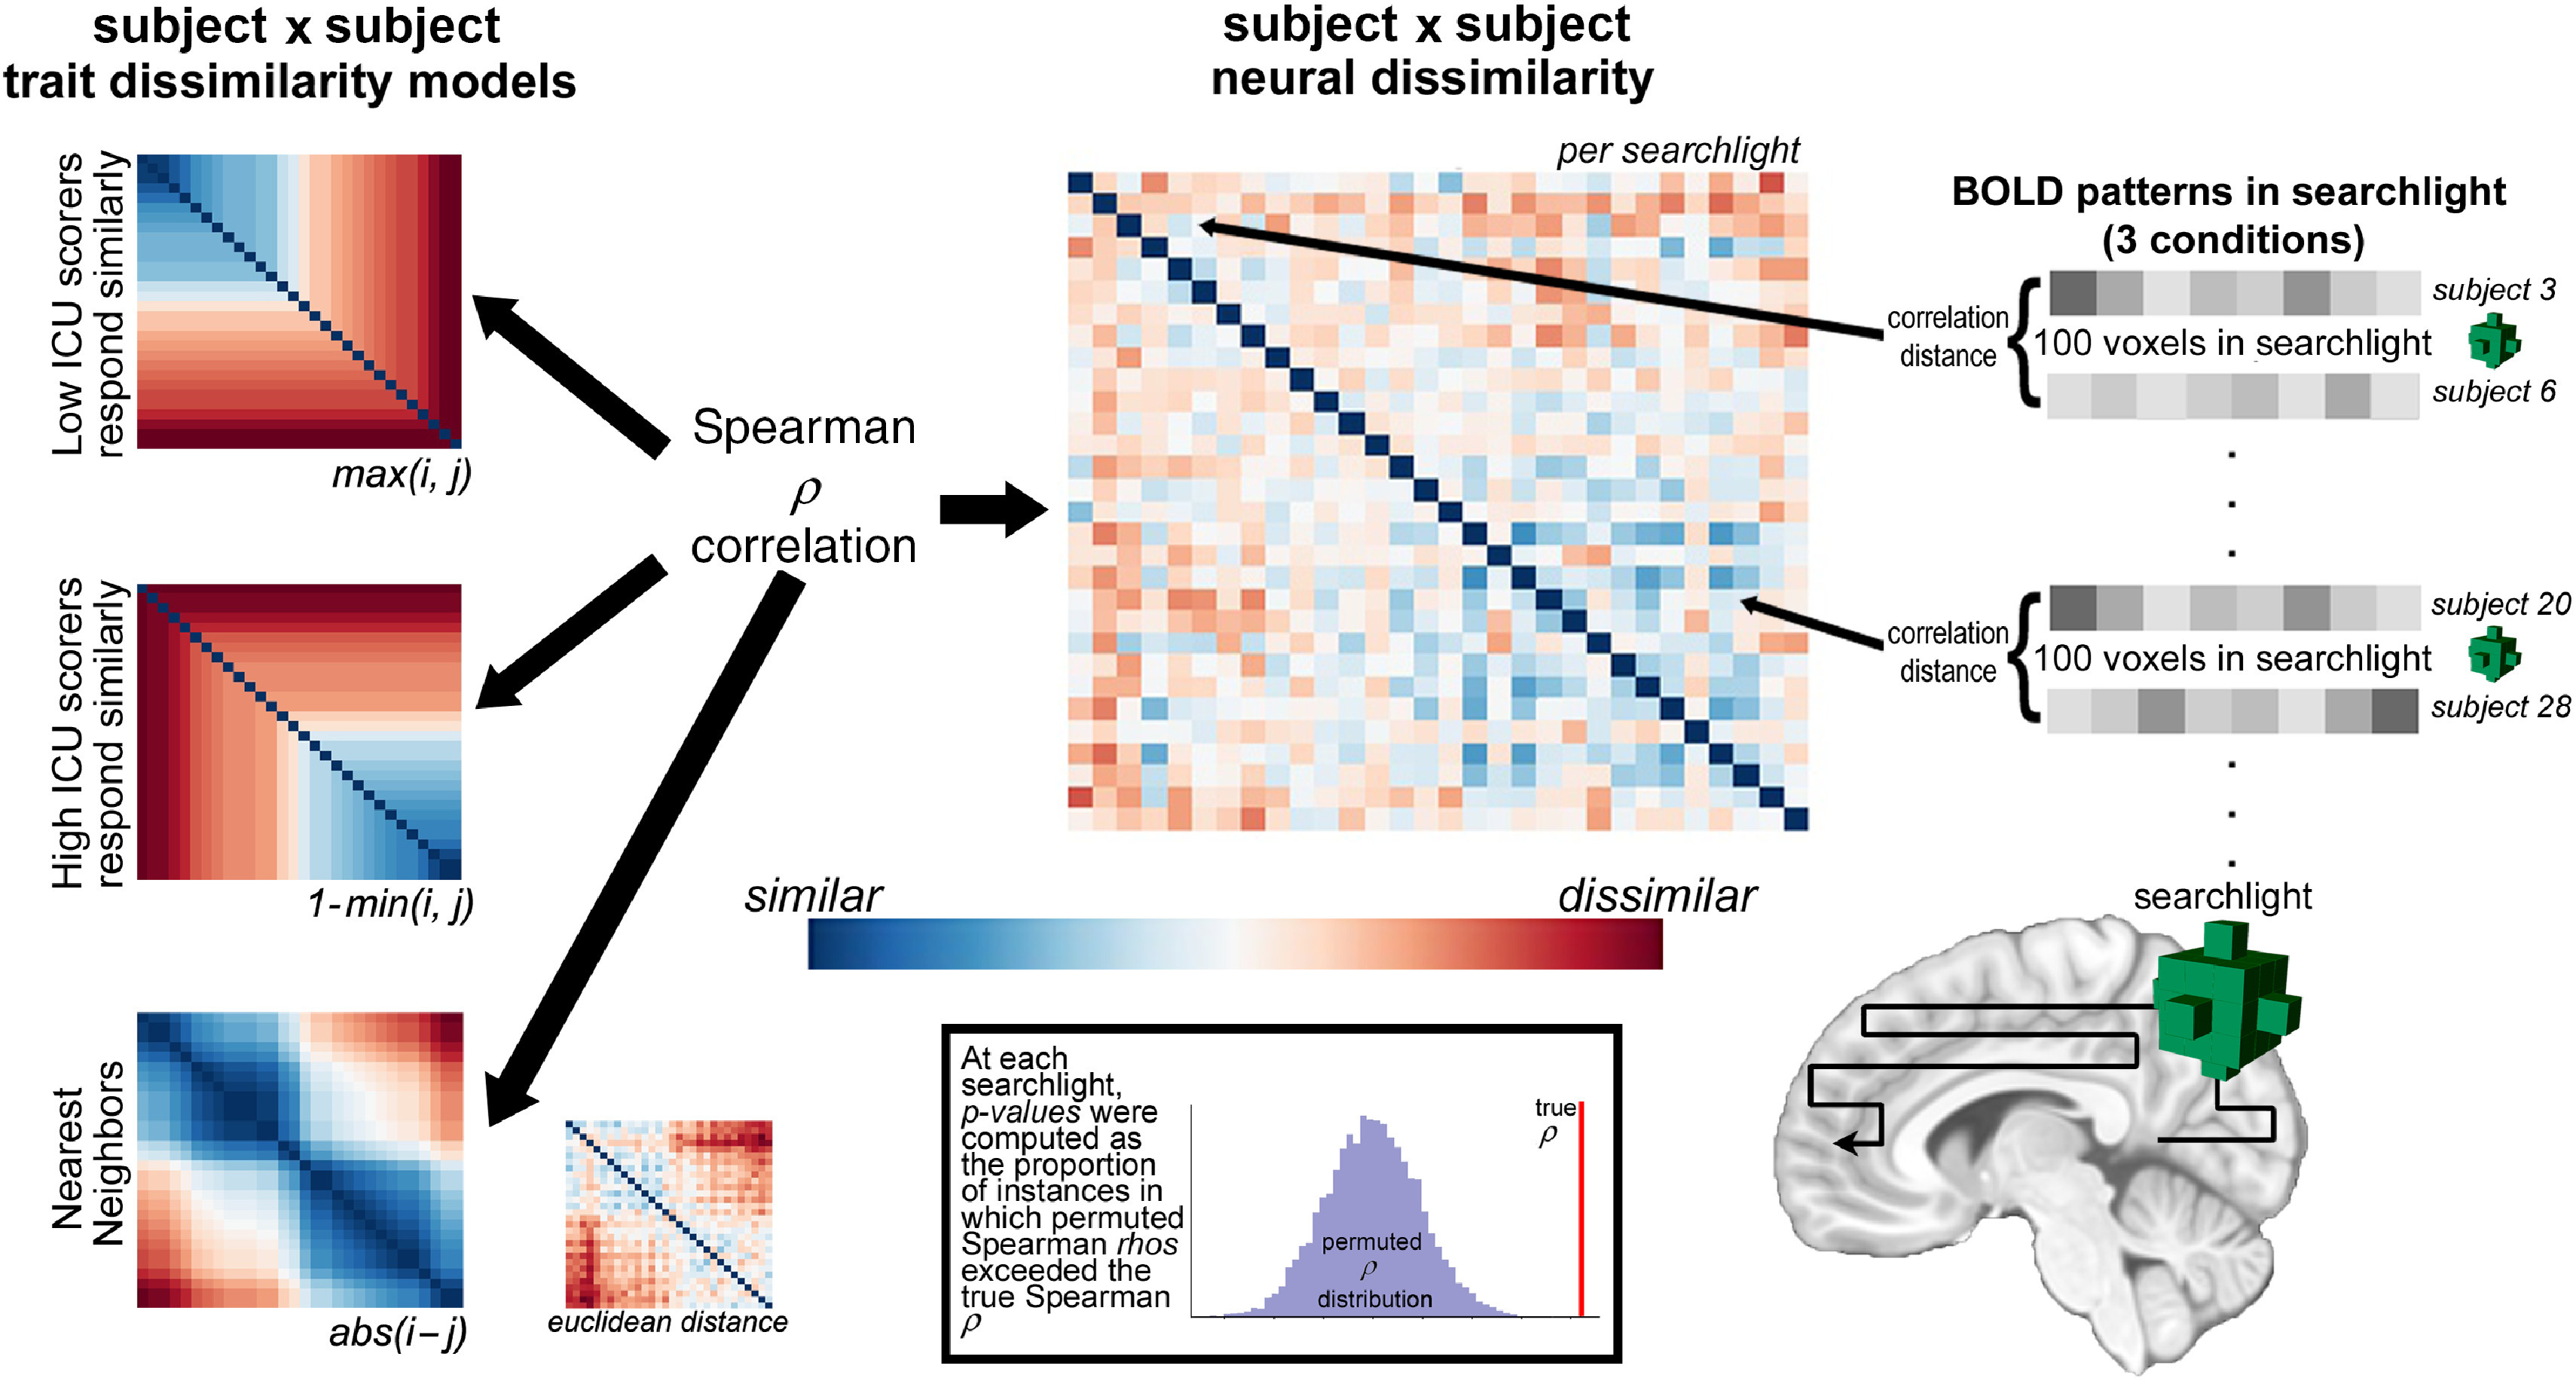

Visualization of Searchlight Intersubject Representational Similarity Analysis. Searchlight Intersubject Representational Similarity Analysis (IS-RSA) consisted of the following steps: (1) We computed three subject × subject disimilarity matrices based on CU summary scores across subjects. The first matrix tested a model in which low scoring CU adolescents’ neural response patterns were more alike while all others’ were different from each other; the second matrix tested a model in which high scoring CU adolescents’ neural response patterns were more alike while all others’ were different from each other; and the third matrix tested a model where adolescents’ neural response patterns were similar to each other in a relative rather than an absolute sense. Depicted trait dissimilarity models are sorted by ICU total scores in ascending order. (2) For each condition (“Afraid for you”, “Afraid for self”, “Afraid of you”), we then computed a subject × subject neural dissimilarity matrix within 100-voxel searchlights across gray matter. (3) Again for each condition, we vectorized the lower triangle of each matrix and performed a Spearman ρ correlation at each searchlight between intersubject behavioral dissimilarity and intersubject neural dissimilarity matrices, and assigned the ρ statistic to the center voxel in the searchlight. (4) Statistical significance was determined using a Mantel permutation test, in which both the rows and columns of the subject × subject model dissimilarity matrix were shuffled and the Spearman correlation between both correlation matrices was recomputed 1000 times to generate an empirical null distribution of rank correlations. (5) At each searchlight, we calculated the p-value as the proportion of instances in which the permuted Spearman ρ statistic exceeded the true Spearman ρ statistic.